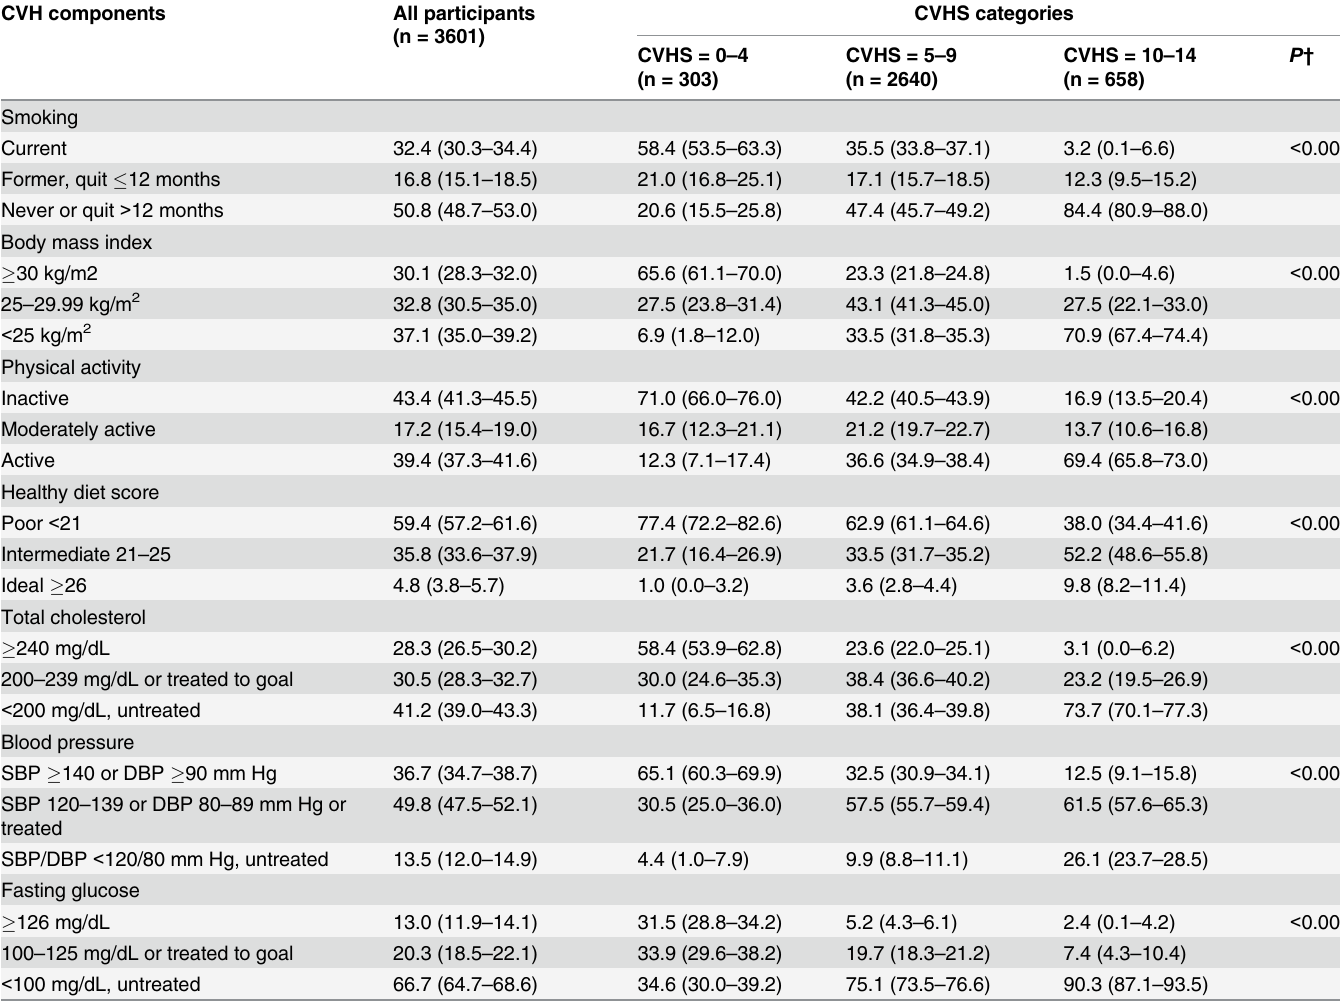
Table 3. Prevalence (95% CI) * of cardiovascular health (CVH) components by cardiovascular health score (CVHS)